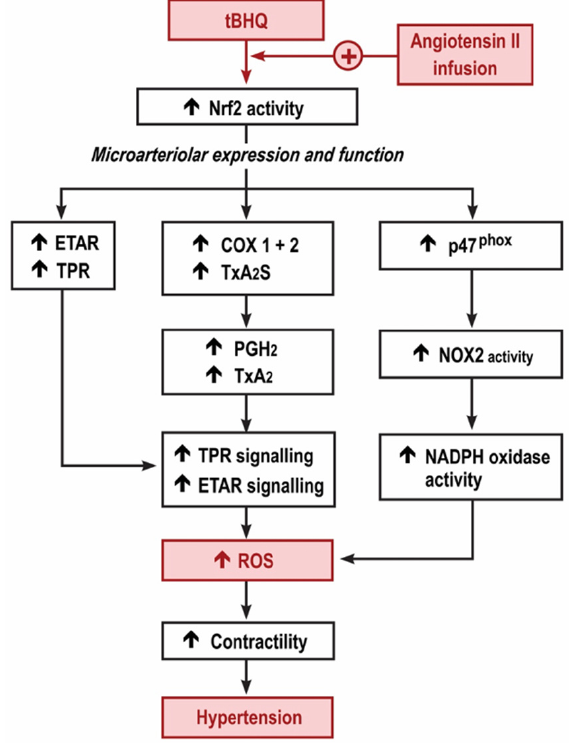
Figure 6. Graphical depiction of the hypothesis for the early increase in reactive oxygen species and microvascular dysfunction with tert-butylhydroquinone during the angiotensin II infusion. Nrf2, nuclear factor erythroid factor E2-related factor 2; TPR, thromboxane prostanoid receptors; ETAR, endothelin type A receptors; COX, cyclooxygenase; TxA 2 S, thromboxane A 2 synthase; NOX, neutrophil oxidase; NADPH, nicotinamide adenine dinucleotide phosphate.